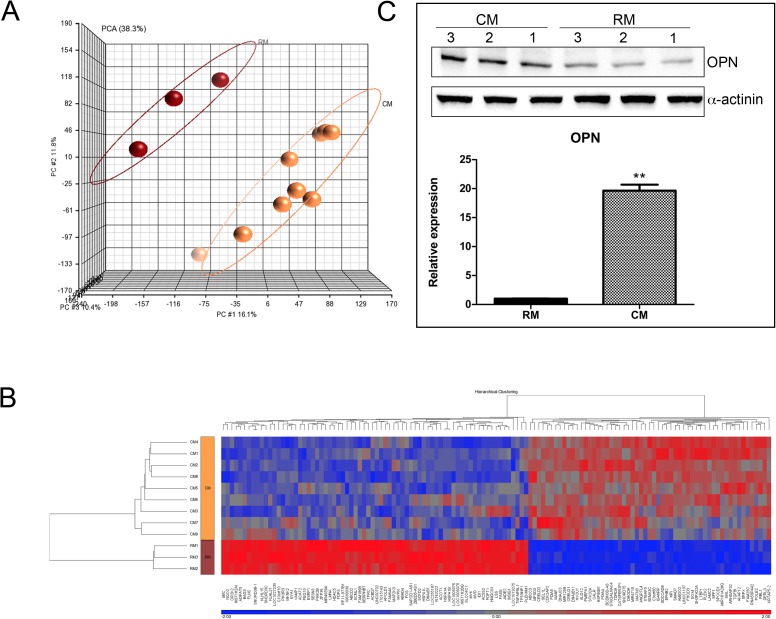
Molecular characterization of omental fat CM-treated PANC-1 cells.(A) PCA of gene expression microarray data. The PCA graphs of global gene expression data were computed using Partek GS, version 6.6; RM control samples are shown as red spheres, n = 3; CM samples are shown as yellow spheres, n = 9. (B) Affymetrix microarray hierarchical clustering performed on mRNA of PANC-1 cells treated with omental fat CM compared to RM. A colored bar indicating the standardized log2 intensities accompanies the expression profile. (C) qRT-PCR validation of the expression levels of OPN in PANC-1 cells pretreated with omental fat CM compared to RM, n = 6. Cells were analyzed by Western blot for the expression of OPN protein levels. α-actinin was used as a protein loading control, n = 6.